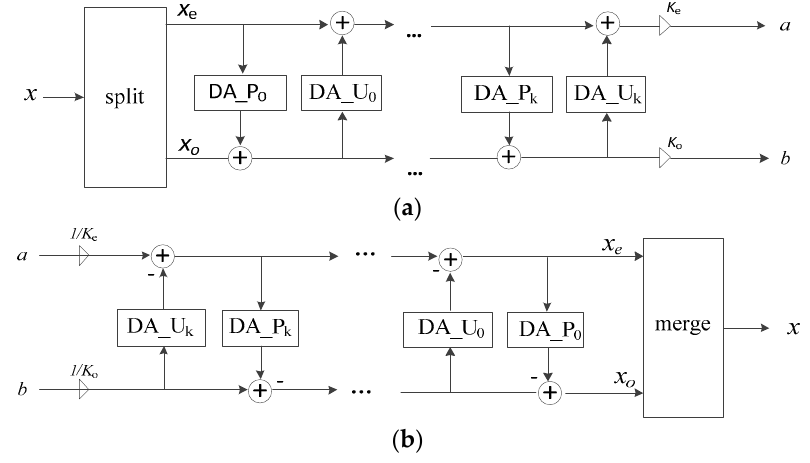
Figure 2. Generic 1-D directional lifting wavelet transform. ( a ) Forward decomposition. ( b ) Reverse synthesis.